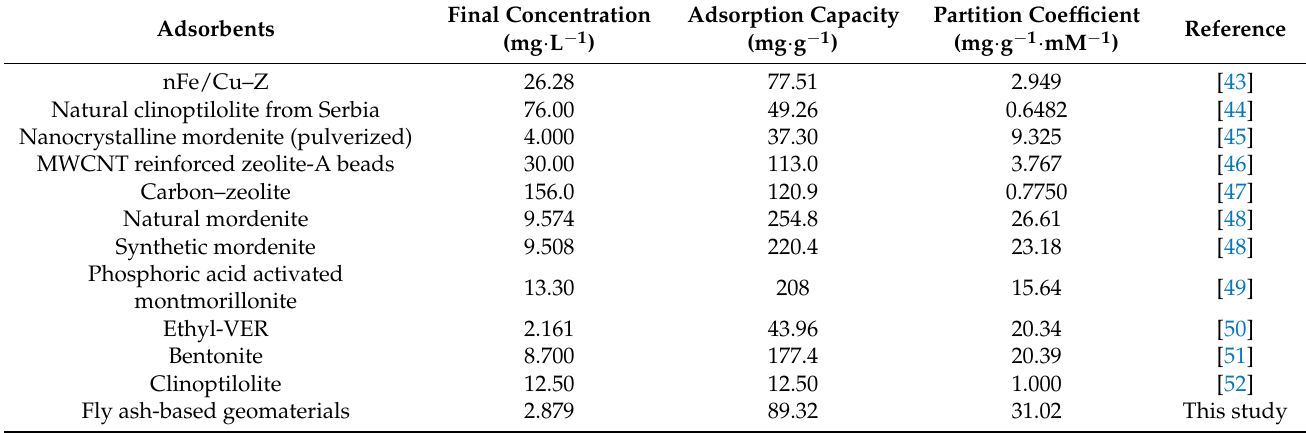
Table 5. The comparison of adsorption properties of several